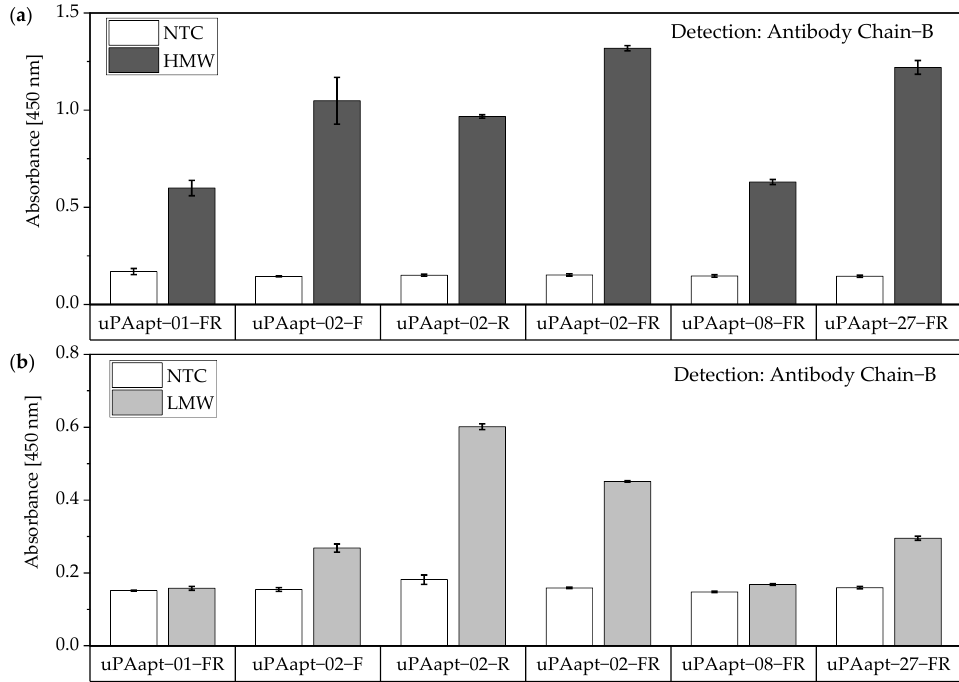
Figure 9. Aptamer – Antibody-based sandwich assay for detection of HMW- and LMW-uPA by Ab Chain B. HMW- uPA could be detected using all uPA aptamers while only uPAapt−02, uPAapt−03, uPAapt−06, uPAapt−26 , and uPAapt−27 captured LMW -uPA and could therefore be detected by Ab Chain B, which bind both uPA forms due to binding to the B-Chain of uPA. The absorbance for each sample is given as the mean value of technical replicates. Error bars represent the range of measured values. Number of records n = 2.